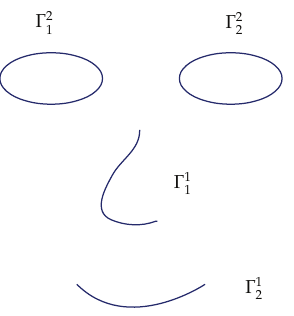
Figure 2: An example of an exterior